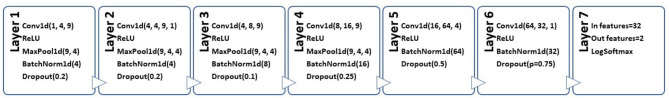
Architecture diagram of DemCNN, a custom PyTorch convolutional neural network for speech classification.